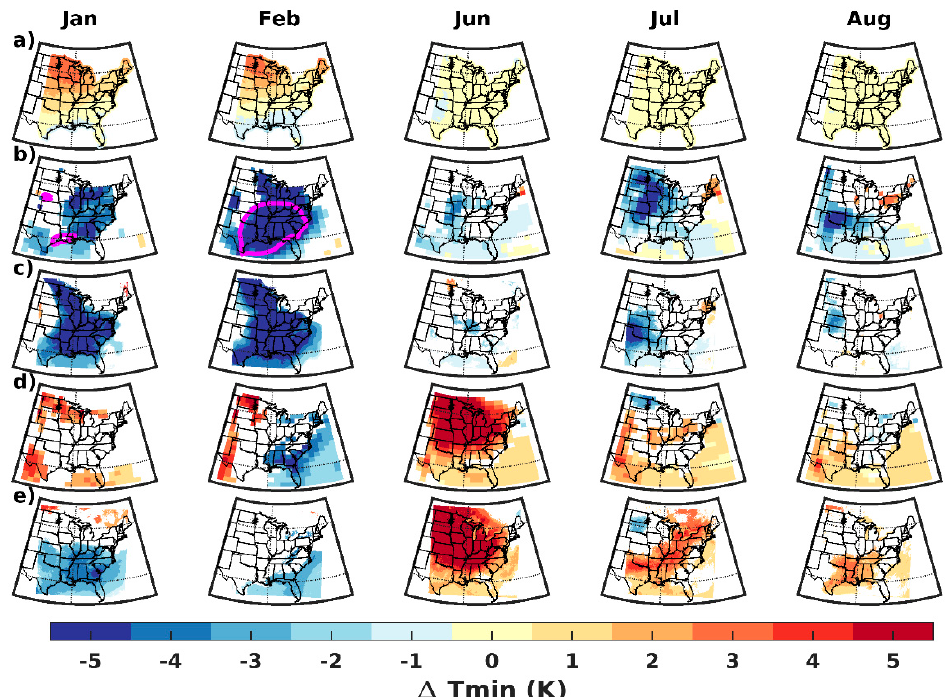
Figure 4. Monthly mean minimum 2-m temperature anomalies (Tmin, in Kelvin) differenced by ENSO phase (strong El Niño–weak La Niña) for the ( a ) NOAA ENSO Climate Normals dataset [10], ( b ) HadGEM2 output for the two historical years simulated using HadGEM2-WRF, ( c ) HadGEM2- WRF historical climate simulations at 4-km domain resolution, ( d ) HadGEM2 output for the two matching WRF future simulated years, and ( e ) HadGEM2-WRF future climate simulations. Differences in ( b – e ) are only shown for grid cells for which a two-sample t test indicates they are significant at a 95% confidence interval. The magenta lines in ( b ) show the area covered by a mean Tmin difference of − 0.5 °C for all strong El Niño–weak La Niña events in the historical climate, as simulated by HadGEM2.